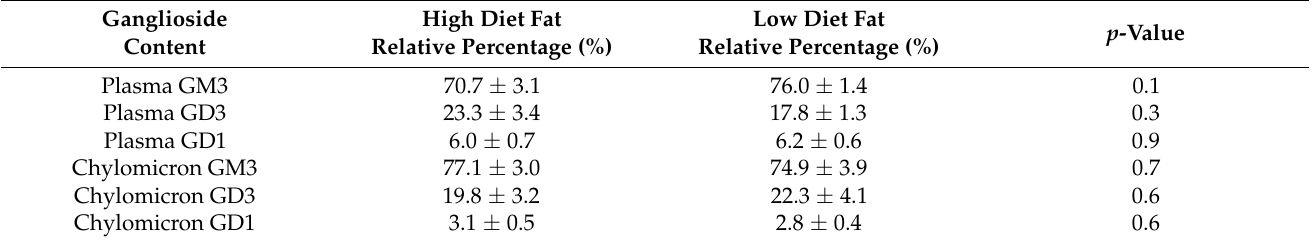
Table 2. Total GM3, GD3, GD1 content in plasma and chylomicrons after consuming a low and high fat